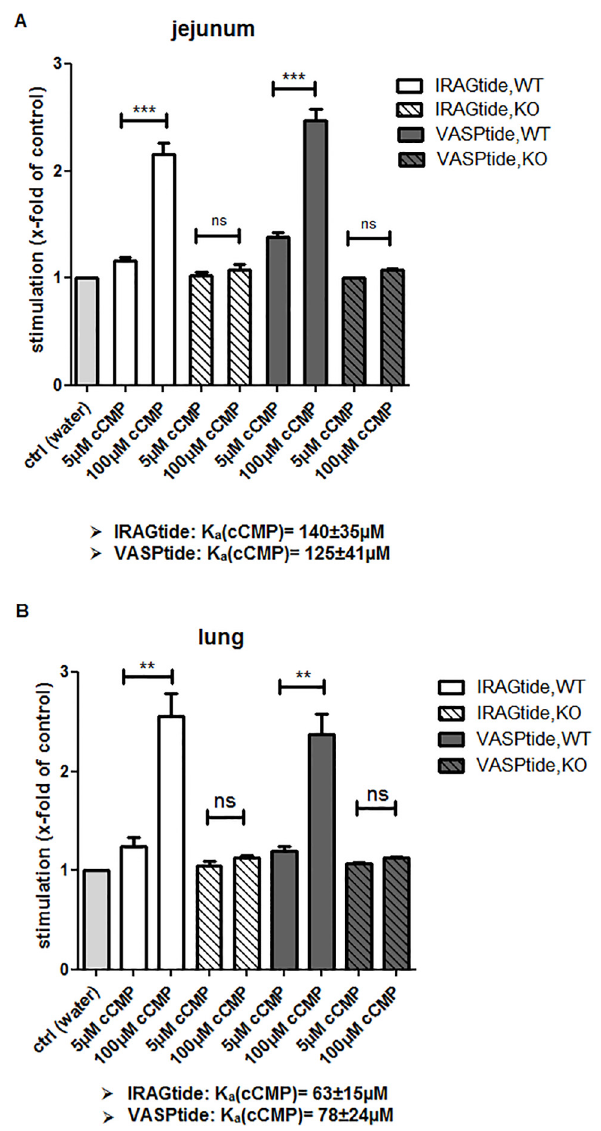
Fig 2. Activation of kinases in tissues of wild type (WT) and cGKI-knockout (KO) mice using two different substrate peptides: VASPtide (RRKVSKQE) and IRAGtide (RRRVSVAV) (A) Stimulation of endogenous cGKs in jejunum tissue lysates after activation with water alone (ctrl) or cCMP (5 or 100 μ M) (B) Same panel as (A) using lung tissue lysates. Data were expressed as x-fold stimulation relative to control samples (water alone). Error bars indicate mean ± SEM of four independent experiments. Asterisks indicate statistically significant differences, ns: not statistically